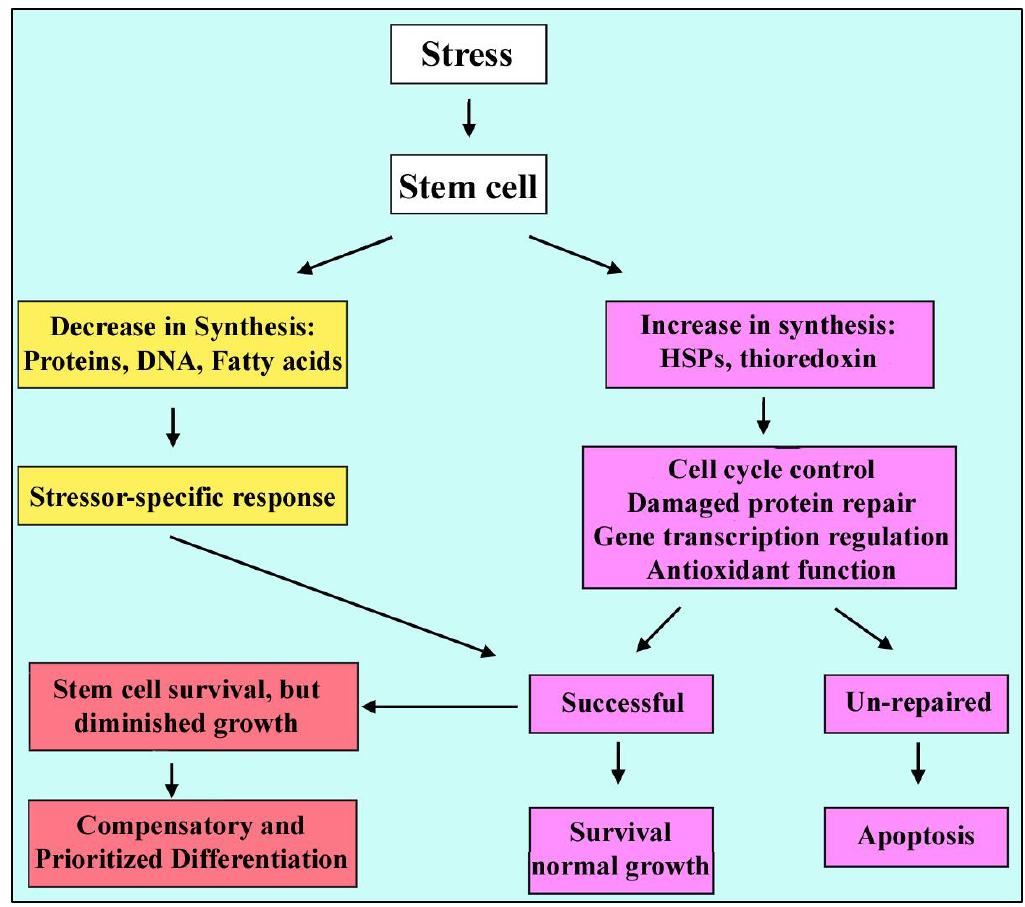
Figure 1. Stem cell adaptive response. Cell will respond to stressors in different ways, through reducing the macromolecular production and increasing the heat shock